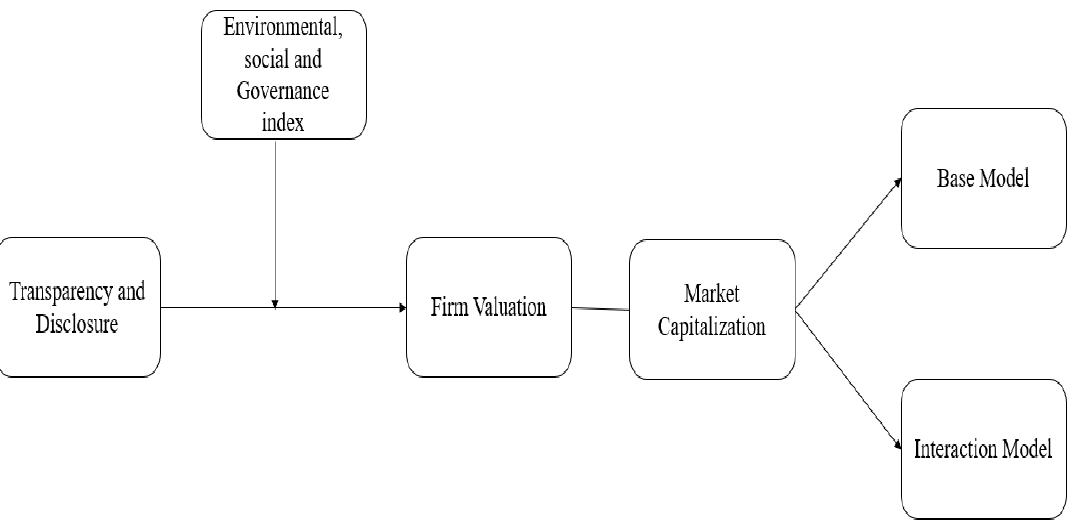
Figure 1. Conceptual model. Source: Author’s contribution. Note: Figure 1 explains the strategy adopted for achieving the empirical results for the current study.